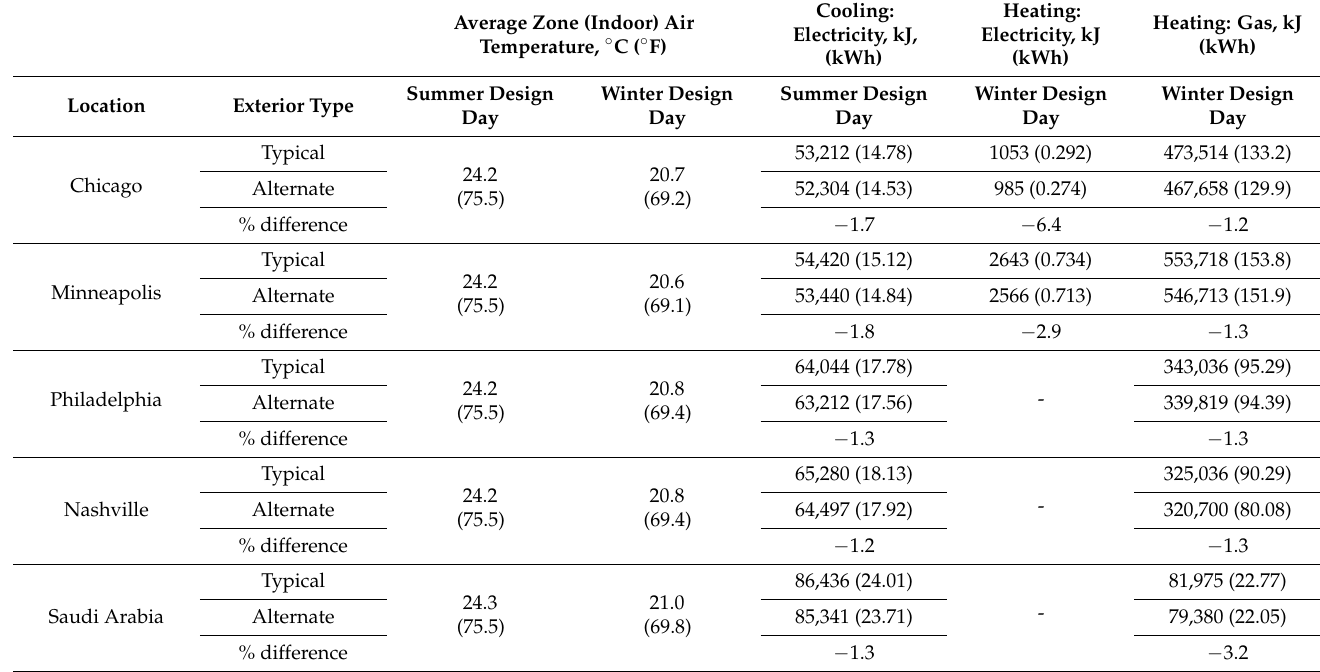
Table 10. Results for midrise apartment building reference model building energy